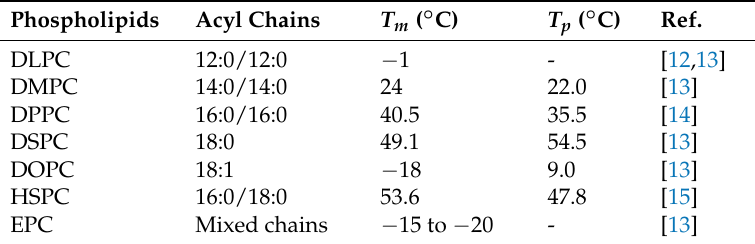
Table 1. Phase pre-transition ( T p ) and transition ( T m ) temperatures of fully hydrated